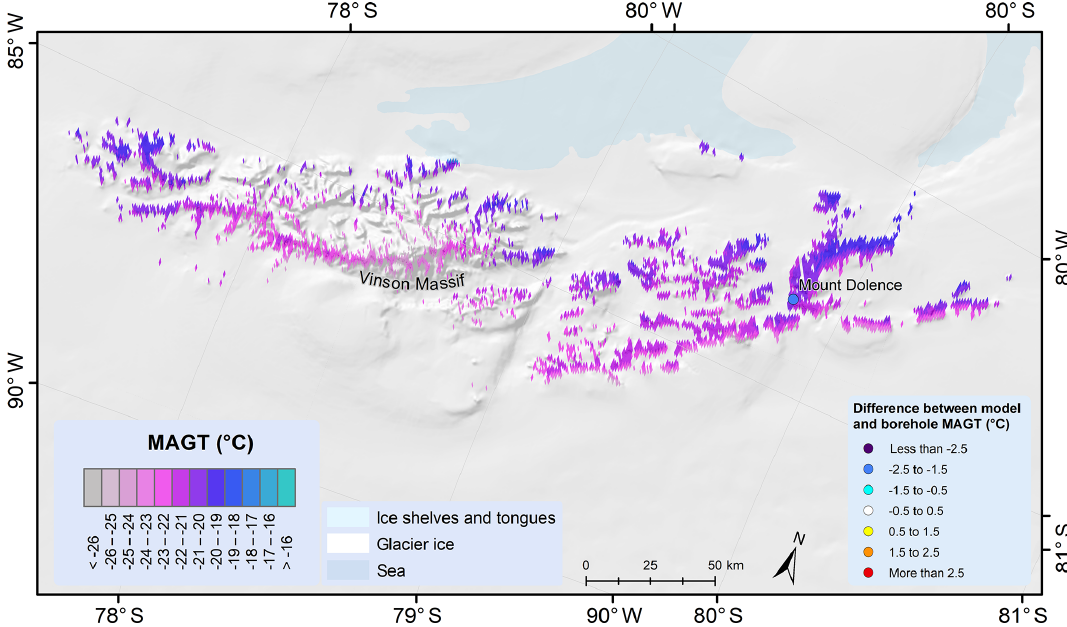
Figure 10. Permafrost temperature map of the Ellsworth Mountains and differences between borehole and modelled MAGT. See Fig. 1 for